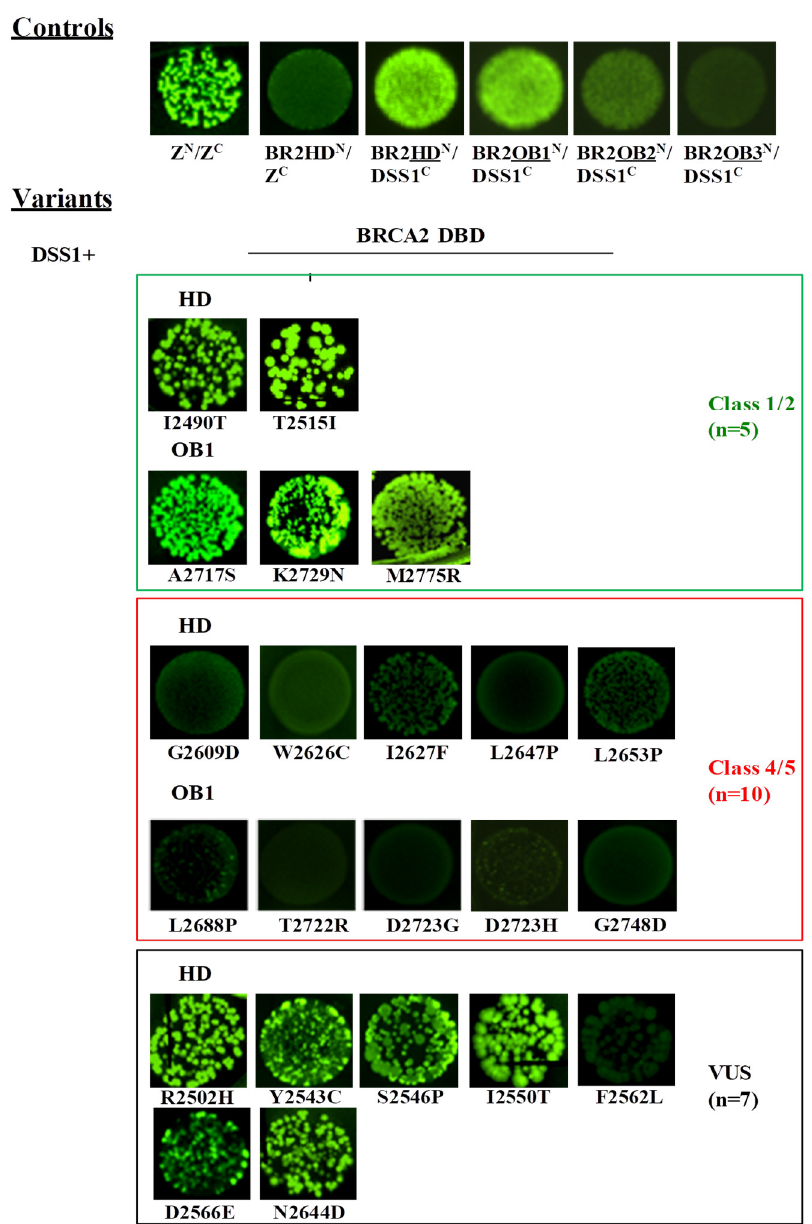
Figure 5. Detection of the DSS1/BRCA2 interaction by GFP-fragment reassembly assay. Fluorescence was assessed after 24 h of growth at 30 °C followed by 2 days of incubation at RT. All pictures were taken with the same setting of digital camera (long-wave UV light, 365 nm). [Z N , H 6 -NfrGFPZ, Z C , ZCfrGFP, BR2HD N , H 6 -NfrGFPBRCA2HD, BR2OB1 N , H 6 -NfrGFPBRCA2OB1, BR2OB2 N , H 6 -NfrGFPBRCA2OB2, BR2OB3 N , H 6 -NfrGFPBRCA2OB3, DSS1 C , DSS1CfrGFP].